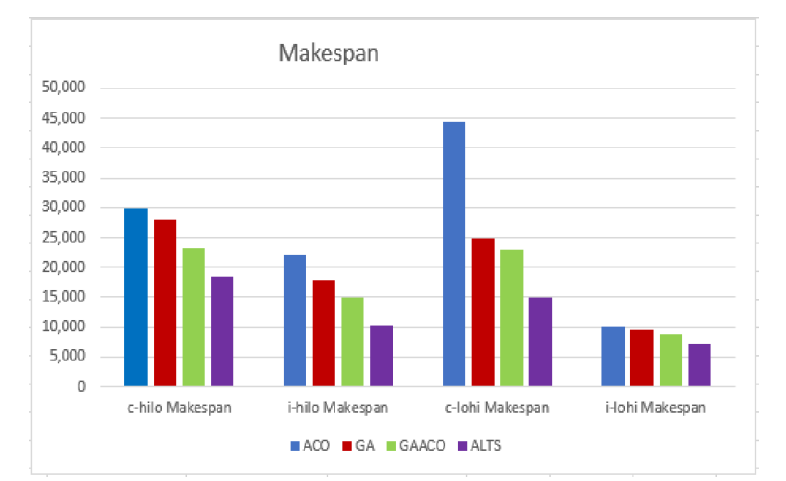
Figure 4. Makespan